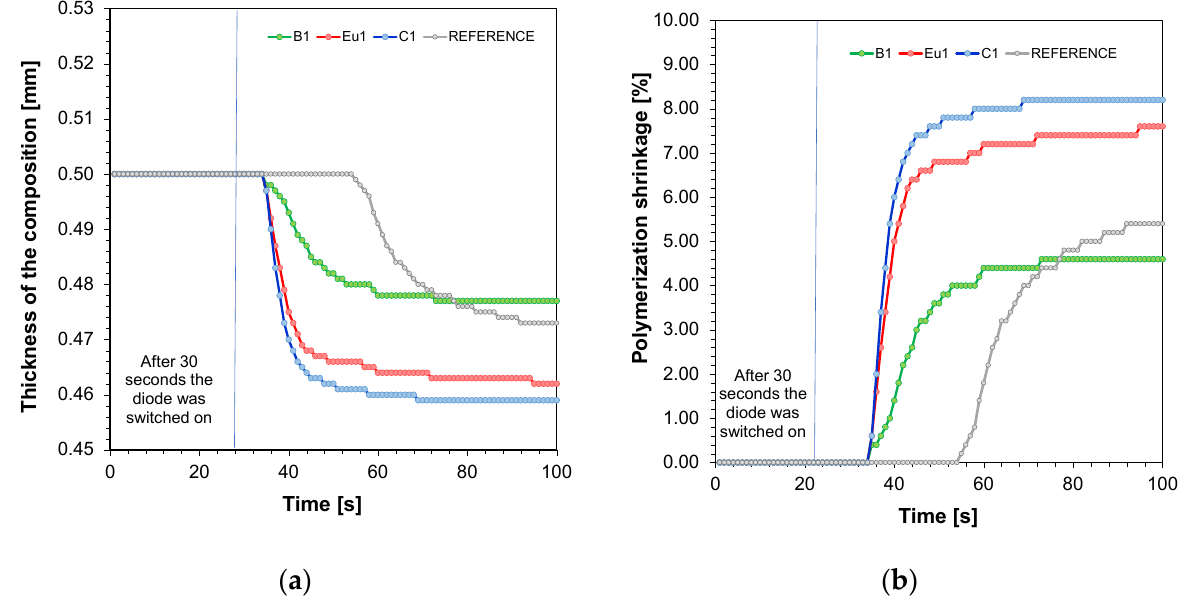
Figure 2. ( a ) Thickness of the compositions versus exposure time for a formulation containing TMPTA, IBOA, and BEDA monomers in a weight ratio of 1:2:7, TPO initiator at 1 wt%, and fluorescent dyes at 0.1 wt%; ( b ) polymerisation shrinkage versus exposure time for a formulation containing TMPTA, IBOA, and BEDA monomers in a weight ratio of 1:2:7, TPO initiator at 1 wt%, and fluorescent dyes at 0.1 wt%.